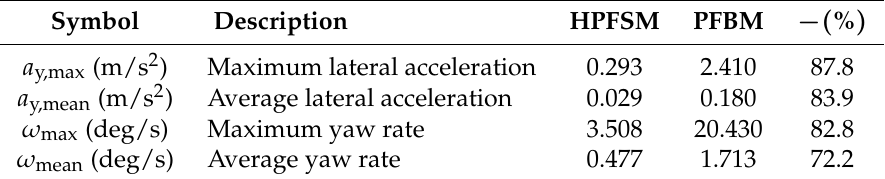
Figure 17. The comparisons of yaw rate and lateral acceleration: ( a ) HPFSM vs. PFBM: Yaw rate; ( b ) HPFSM vs. PFBM: Lateral acceleration. Table 5. Results comparisons in the dynamic